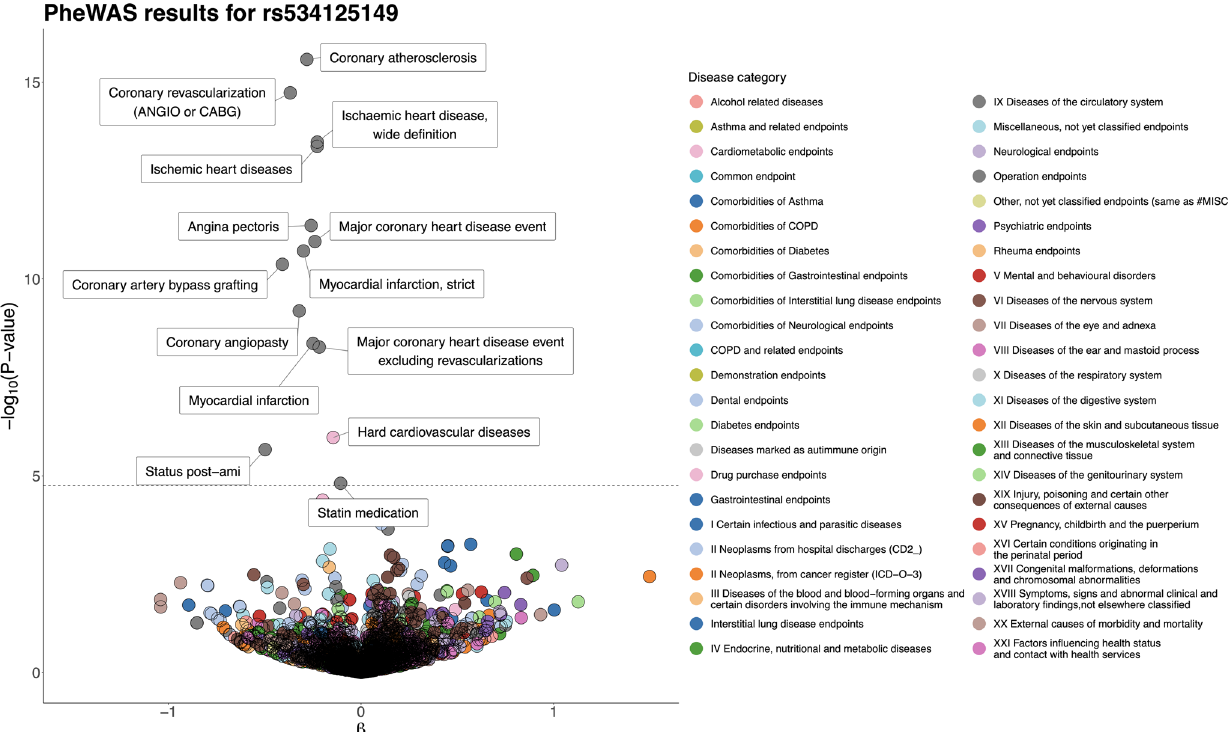
Fig. 4 Phenome-wide association study (PheWAS) results for rs534125149. Total number of tested endpoints is 2861 (A complete list of endpoints analyzed and their de fi nitions is available at https://www. fi nngen. fi /en/researchers/clinical-endpoints). The dashed line represents the phenome-wide signi fi cance threshold, multiple testing corrected by the number of endpoints = 0.05/2861 = 1.75 × 10 − 5 . All endpoints reaching that threshold are labeled in the fi gure.